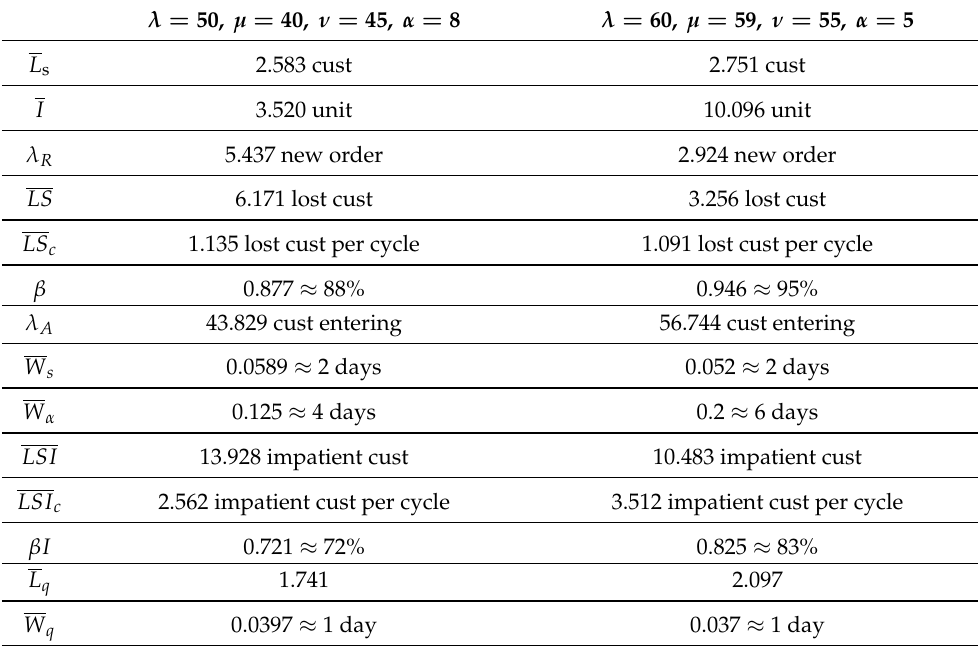
Table 4. The performance measures obtained using a constant order size